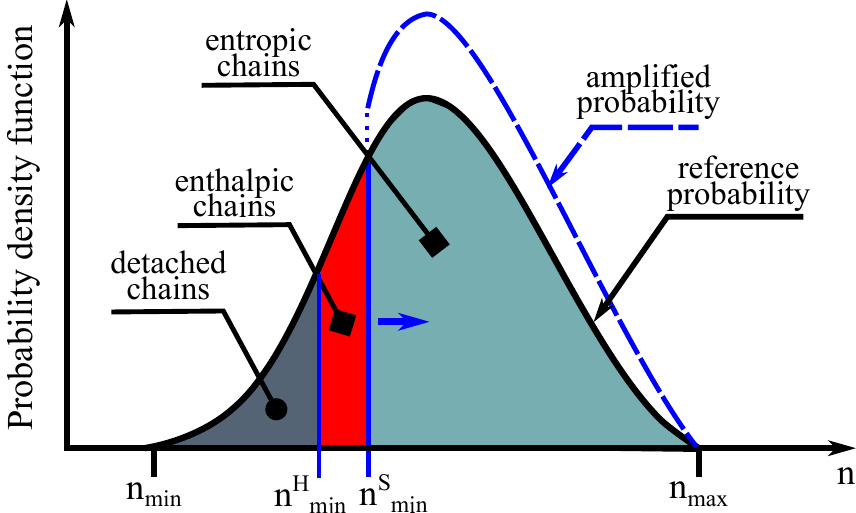
Figure 7. Schematic view of the probability density function over the set of available chain in a particular direction ( D ) during